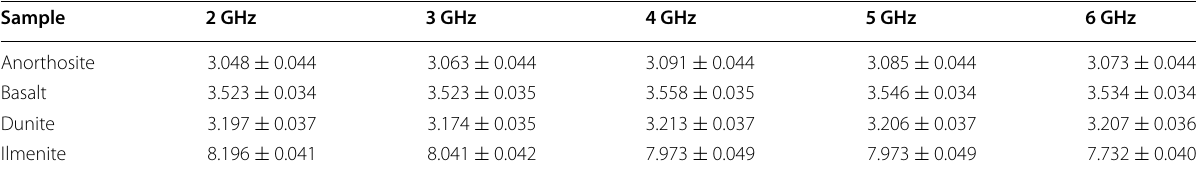
The value shows the average of 5 points below and 5 points above each frequency (e.g., the average of the permittivity from 1.984–2.018 GHz in the case of 2 GHz) In the case of 6 GHz, it is averaged with the 10 points only below the frequency (i.e., the average of the permittivity from 5.966–6.000 GHz)